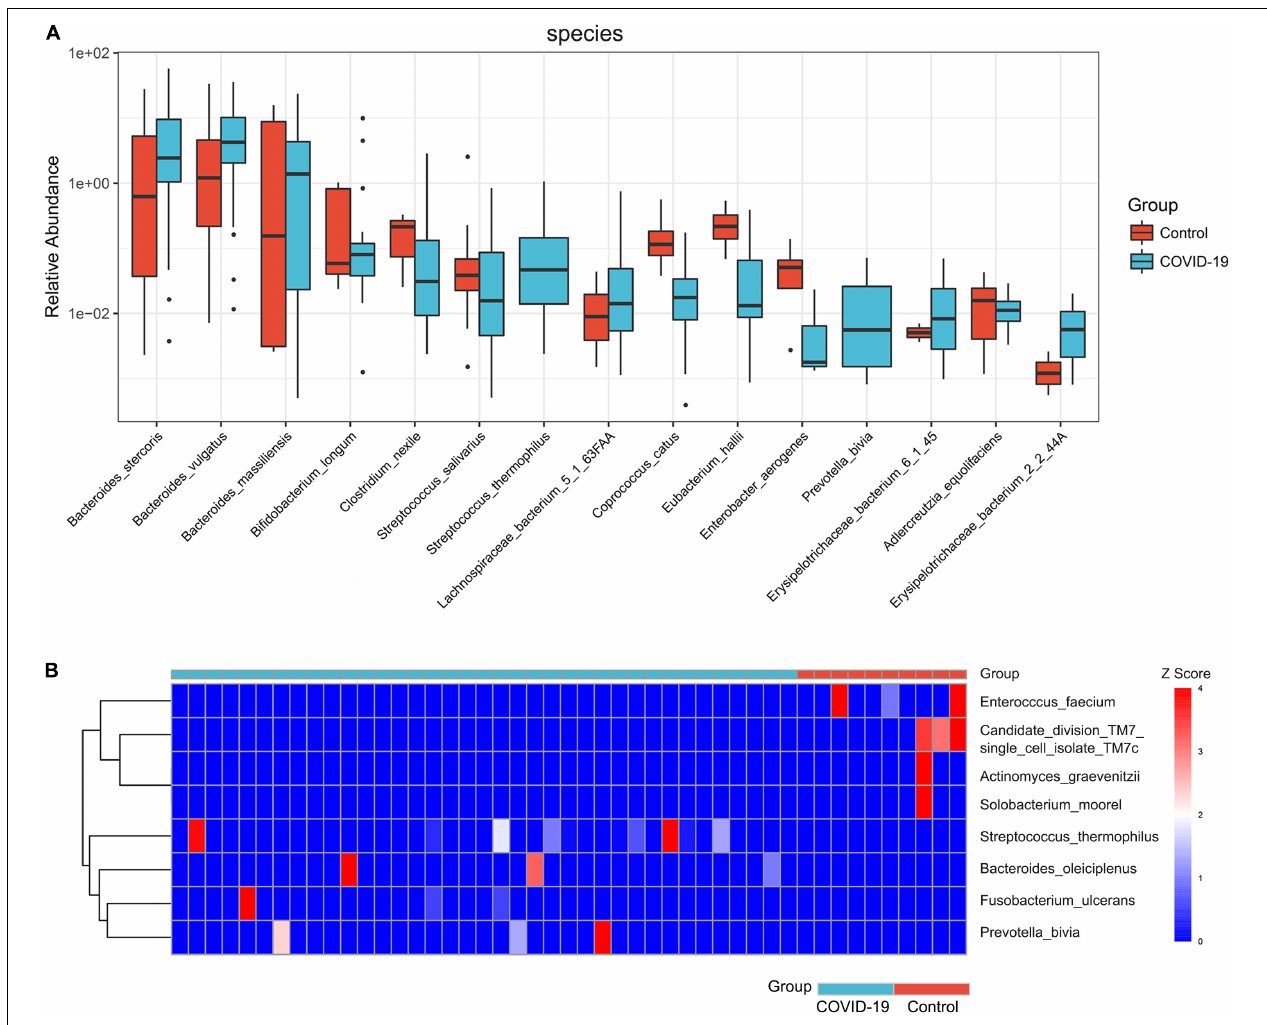
FIGURE 3 | Significant species in patients with COVID-19. (A) Compared with HC ( n = 10), eight species were significantly enriched, whereas seven species were significantly reduced in COVID-19 ( n = 37) (all p < 0.05). (B) A heat map displaying the significantly abundant microbial species in COVID-19 (blue) and healthy control (red). Four species were unique to COVID-19 patients, whereas another four species were specific in HC (all p <